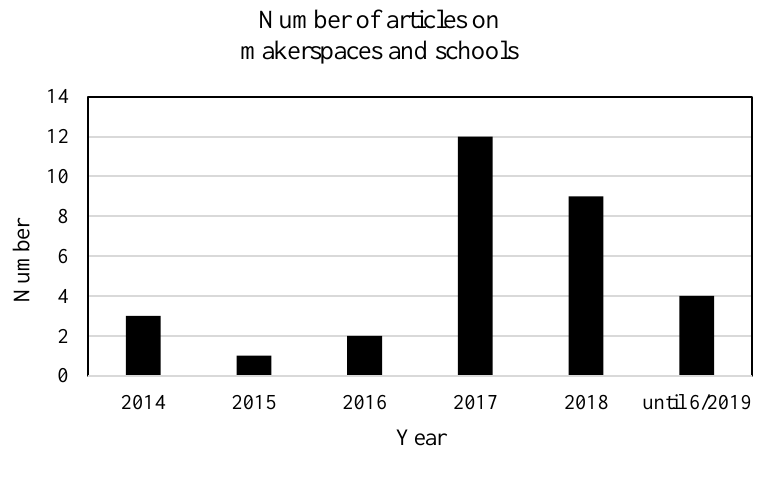
Fig. 2. Number of articles on makerspaces and